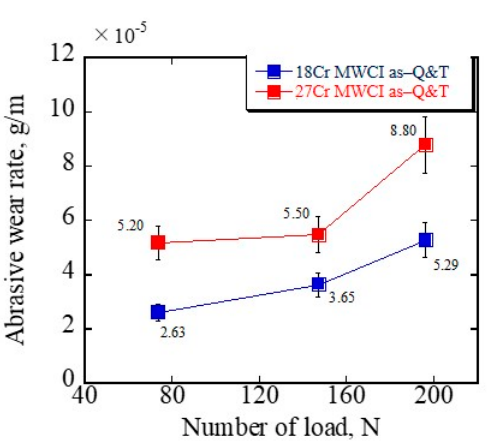
Figure 7. Vickers hardness of each material.